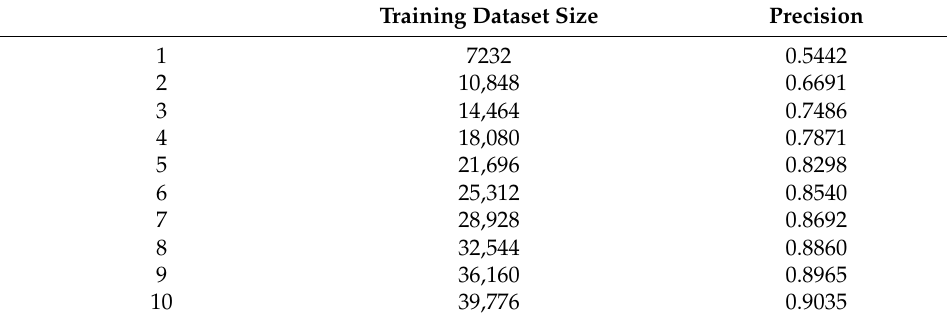
Table 6. Experiment 2 evaluation results.